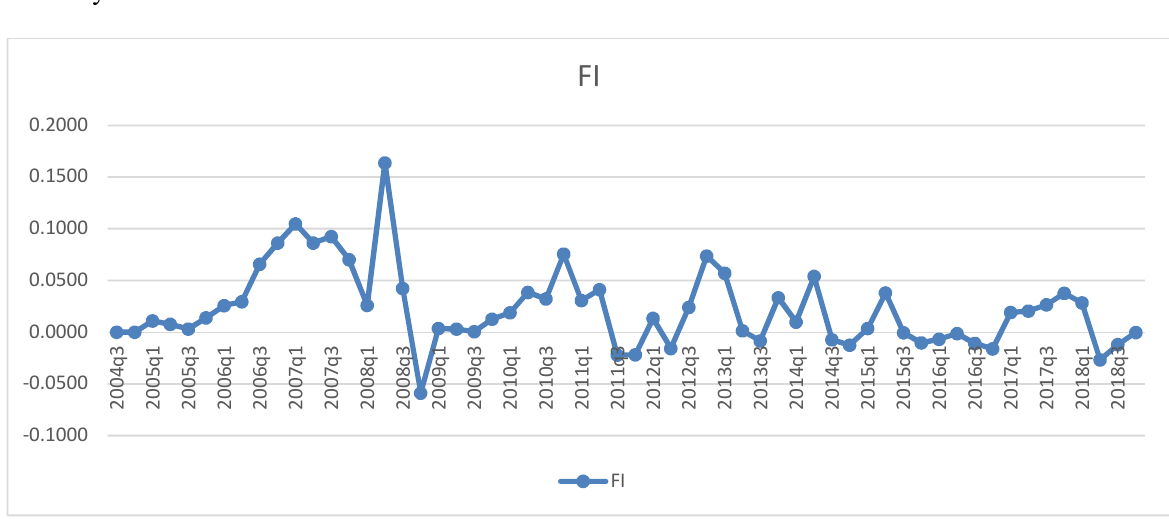
Fig. 4. Net transaction value of foreign investors (FI) in Vietnam